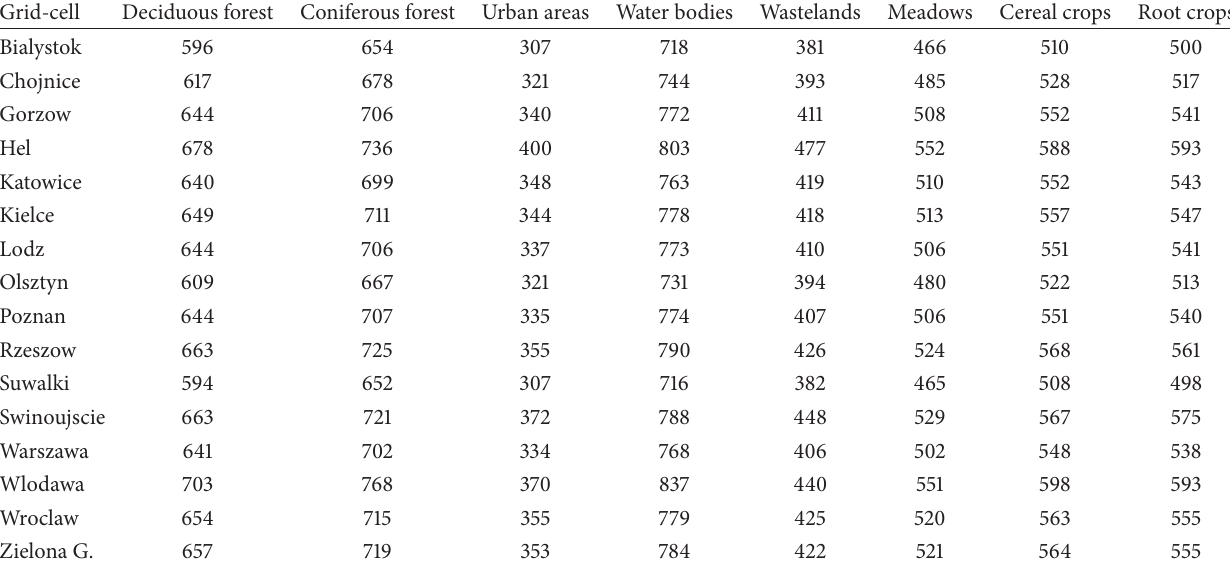
Table 7: The annual values of evaporation [in mm] for different land-use units for the control period 1961–1990 compared to the control period 1961–1990, based on the MPI-M-REMO